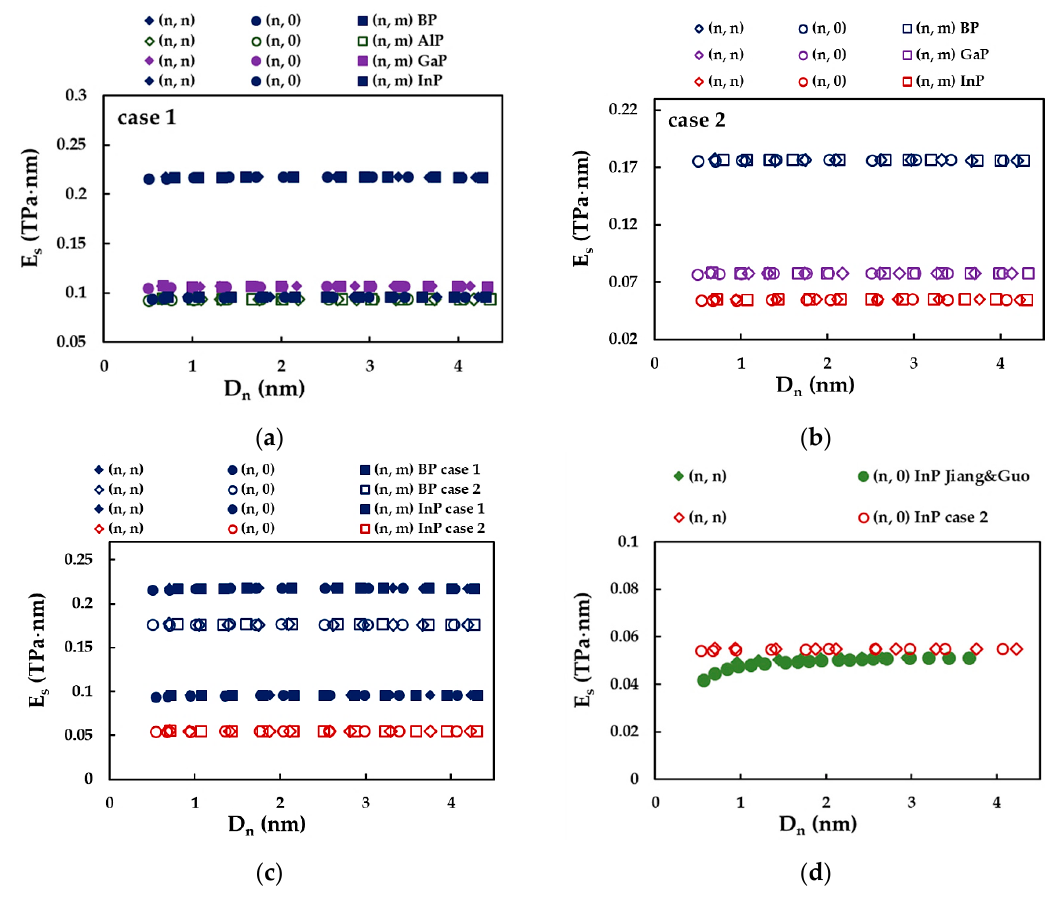
Figure 13. Evolution of surface Young’s modulus, E s , as a function of the nanotube diameter, D n : ( a ) for case 1 of SWBPNTs, SWAlPNTs, SWGaPNTs and SWInPNTs; ( b ) for case 2 of SWBPNTs, SWGaPNTs and SWInPNTs; ( c ) for case 1 and case 2 of SWBPNTs and SWInPNTs; and ( d ) comparison with the literature results [27]. Table 8. Comparison of the current surface Young’s modulus results for phosphide nanotubes with those reported in the literature.